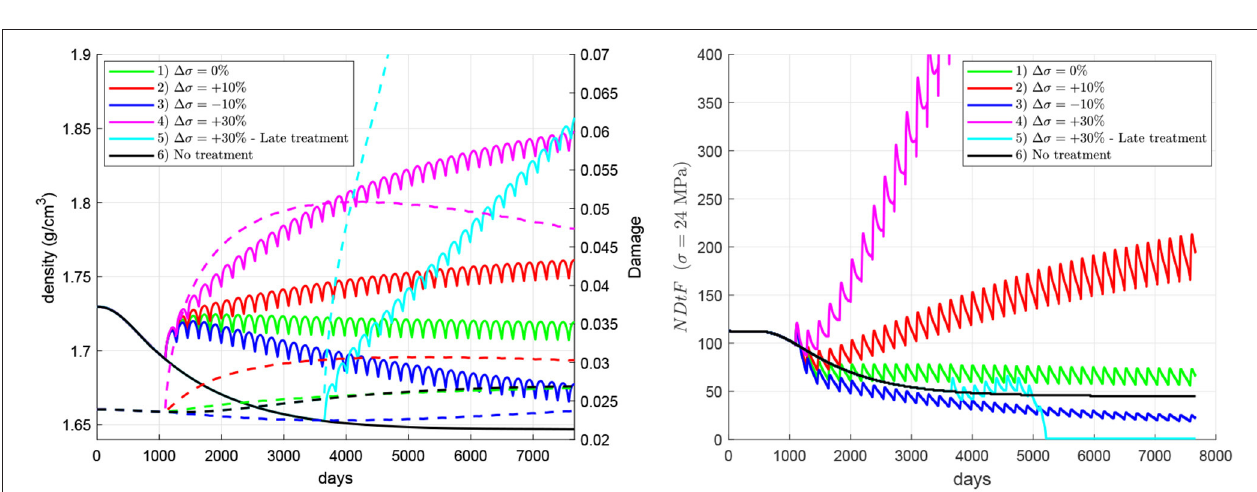
FIGURE 6 | Influence of the time elapsed between the onset of disease and the beginning of the treatment. Evolution of density (left, solid lines), damage (left, dashed lines), and NDtF- σ = 24 MPa (right) for treatment 60Q6.